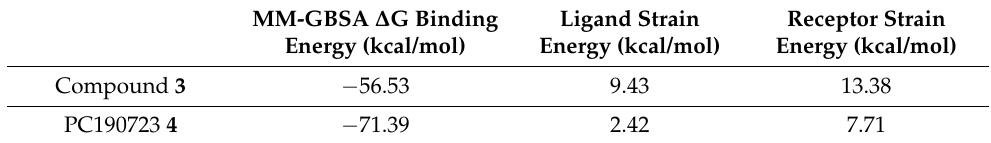
Table 1. MM-GBSA binding energies of compound 3 and PC190723 4 on FtsZ (PDB ID: 4DXD).